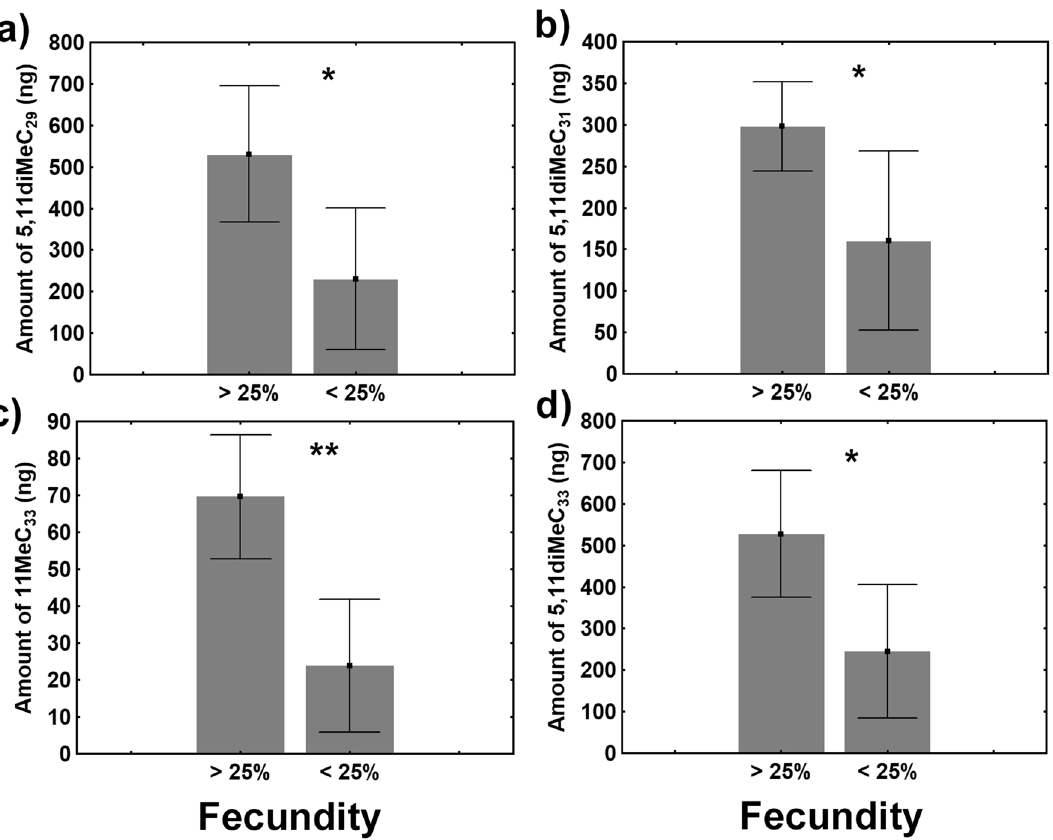
Figure 7. Amounts of 5,11-diMeC 29 ( a ), 5,11-diMeC 31 ( b ), 11-MeC 33 ( c ), and 5,11-diMeC 33 (d) in the CHC profiles of high-fecundity queens (> 25%) (n = 7) and low-fecundity queens (< 25%) (n = 8) (mean ± SE). The asterisks denote significant differences (* p < 0.05; ** p <